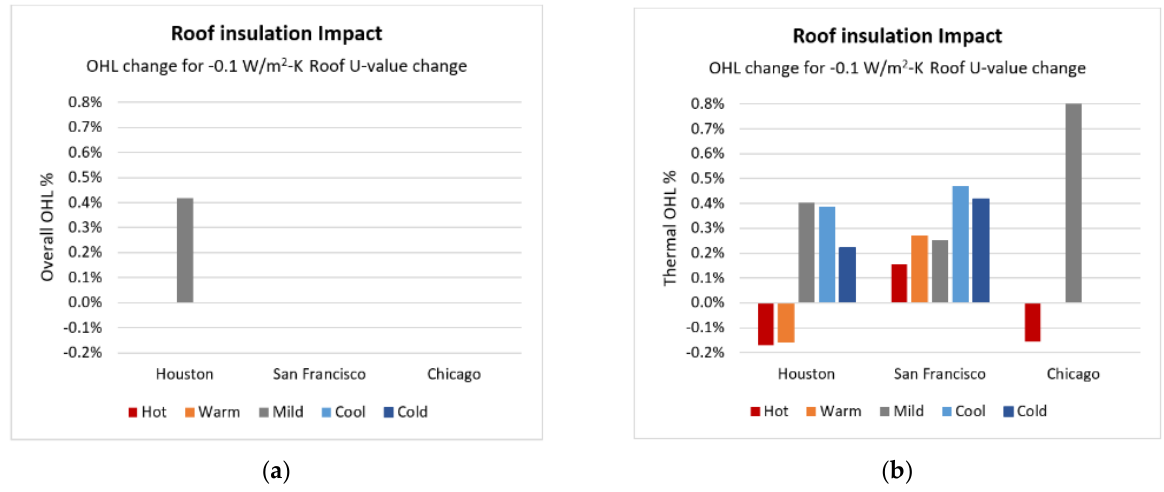
Figure 10. Impact of a 0.1 W/m 2 -K decrease in exterior wall U-value on overall ( a ) and thermal ( b ) OHL.